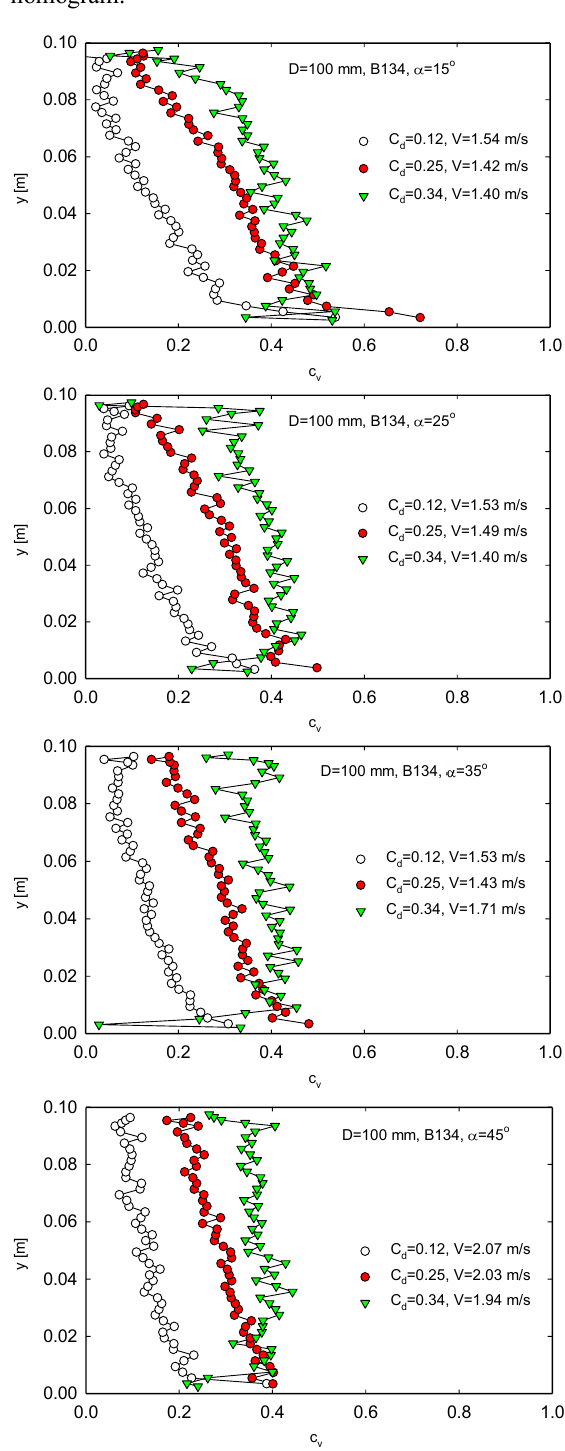
Fig. 9. Effect of slurry transport concentration C d on local concentration